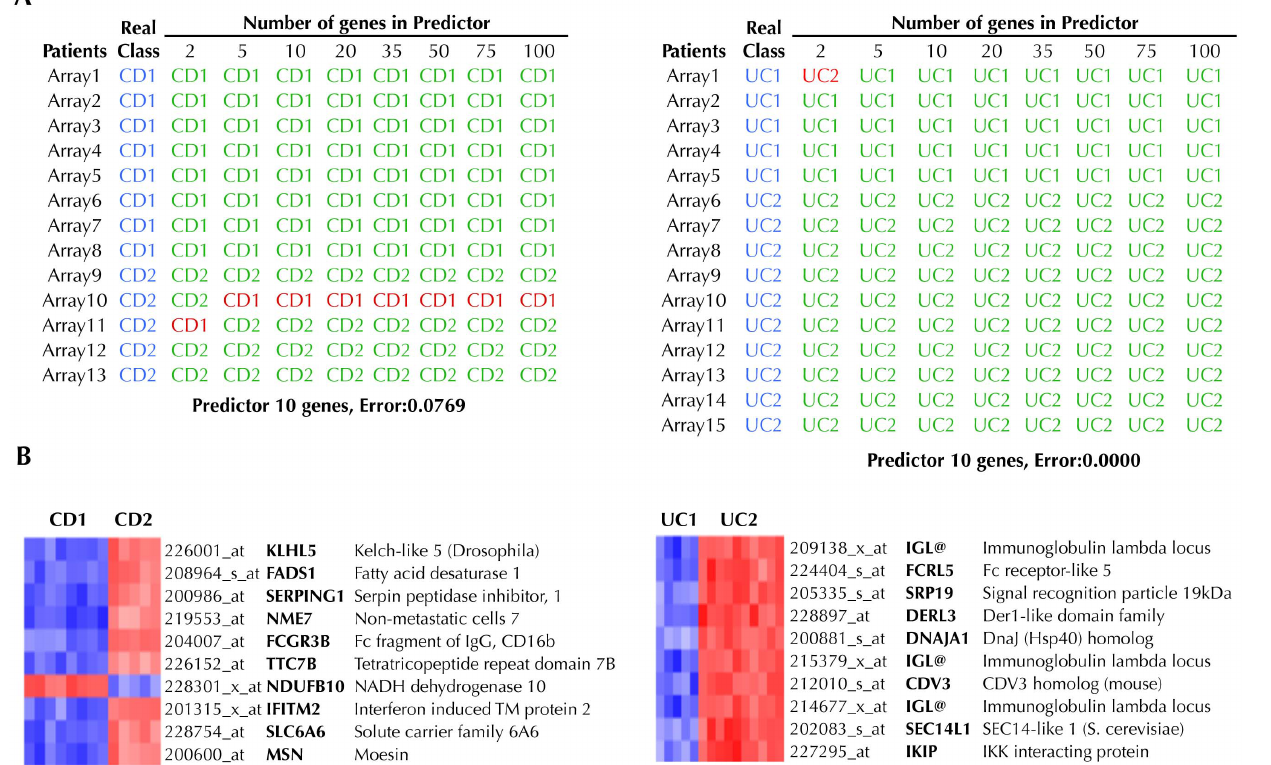
Figure 2. Identification of predictive classifiers of ‘‘High’’ and ‘‘Low’’ inflammation subtypes of Crohn’s disease (CD) and ulcerative colitis (UC). (A) A class predictor was built for both CD and UC using the tool Prophet and the 54,675 probes contained in the chip, using the leave- one-out cross-validation strategy. For each predictor, patients that were correctly classified are shown green, while those patients that the predictor failed to classify correctly are shown in red. (B) Based on the accuracy of each classifier, a 10-gene predictor was selected in both cases, which were able to accurately classify 92% of CD patients and 100% of UC patients. Up-regulated genes are shown in red and down-regulated in blue.